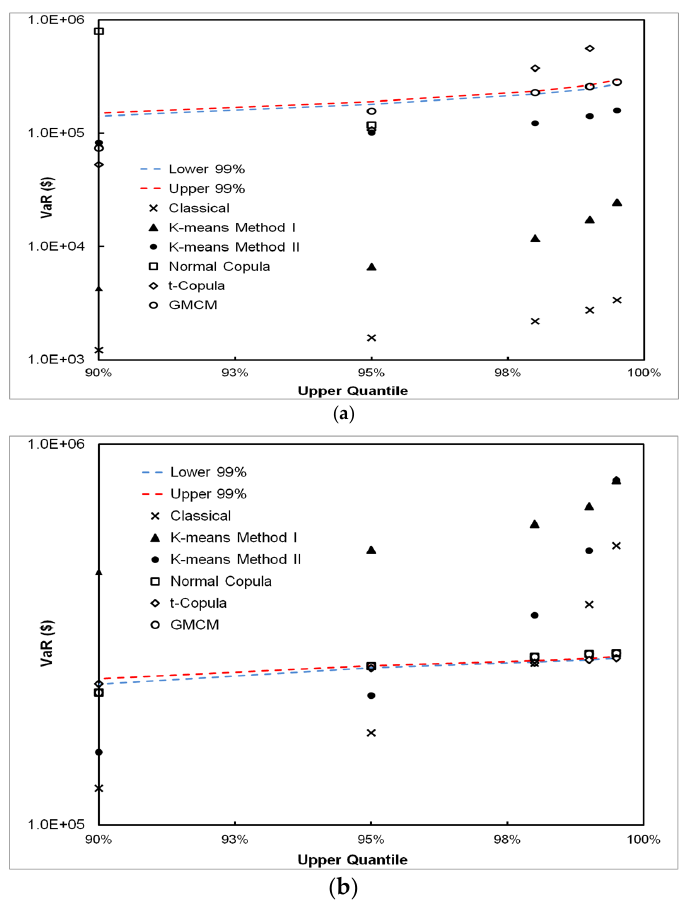
Figure 9. VaR estimates by the classical, DPFS and CPFS methods for the simulated Scenario (IV) ( a ) and Scenario (V) ( b ); GMCM performs the best compared to the true VaR, while the K ‐ means and the classical methods underestimate the true VaR in Scenario (IV). For Scenario (V), the t ‐ Copula performs the best for the perfect correlation relationship between frequency and severity.